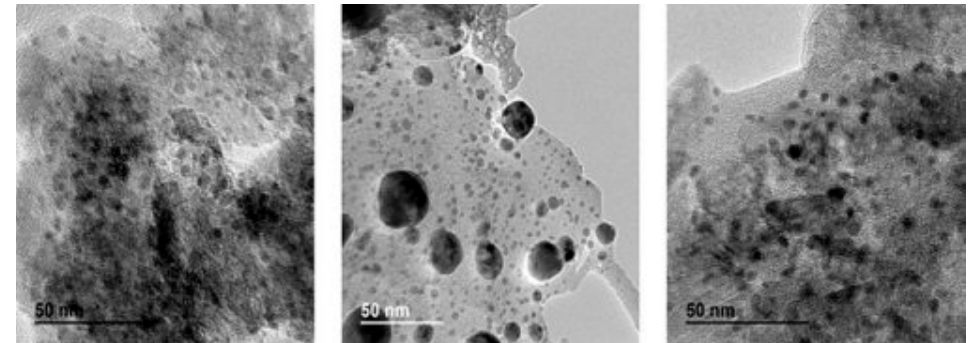
Figure 6. TEM images of 7% Pd/Al 2 O 3 catalysts prepared with different precursors: ( right ) acetate, ( middle ) nitrate, ( left ) chloride. Reprinted from [77], Copyright (2021), with permission from John Wiley and Sons.